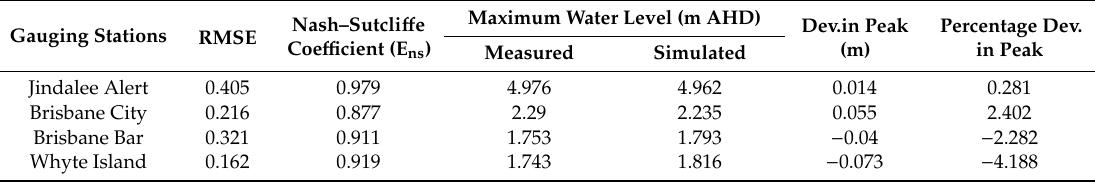
Table 5. Performance indices at gauging stations during calibration of the 2013 flood event.